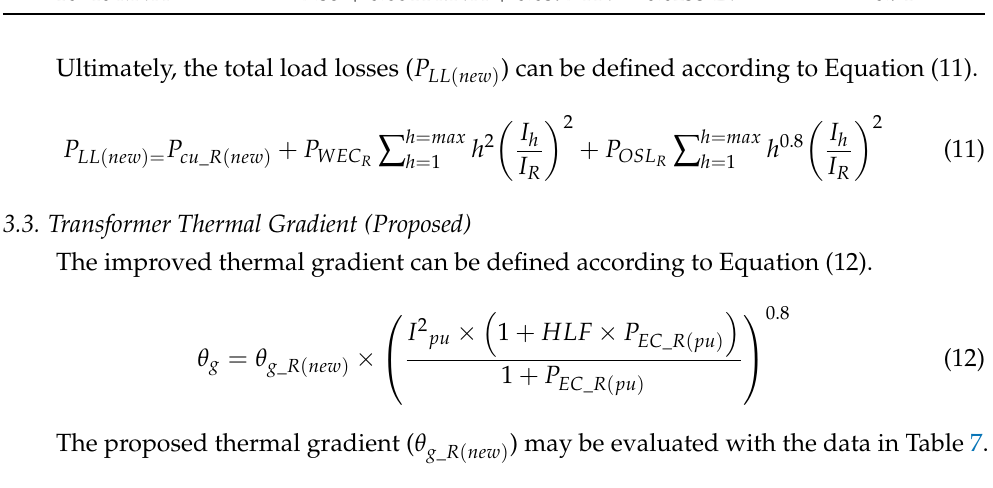
Table 7. Proposed regression models for θ g _ R ( new )